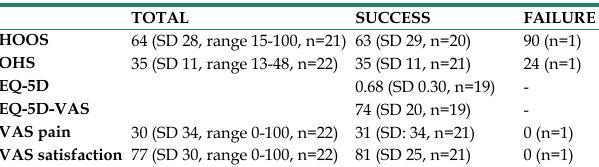
HOOS: Hip disability and Osteoarthritis Outcome Score, OHS: Oxford Hip Score, EQ-5D: EuroQol five dimensions questionnaire, VAS: Visual Analogue Score, SD: Standard